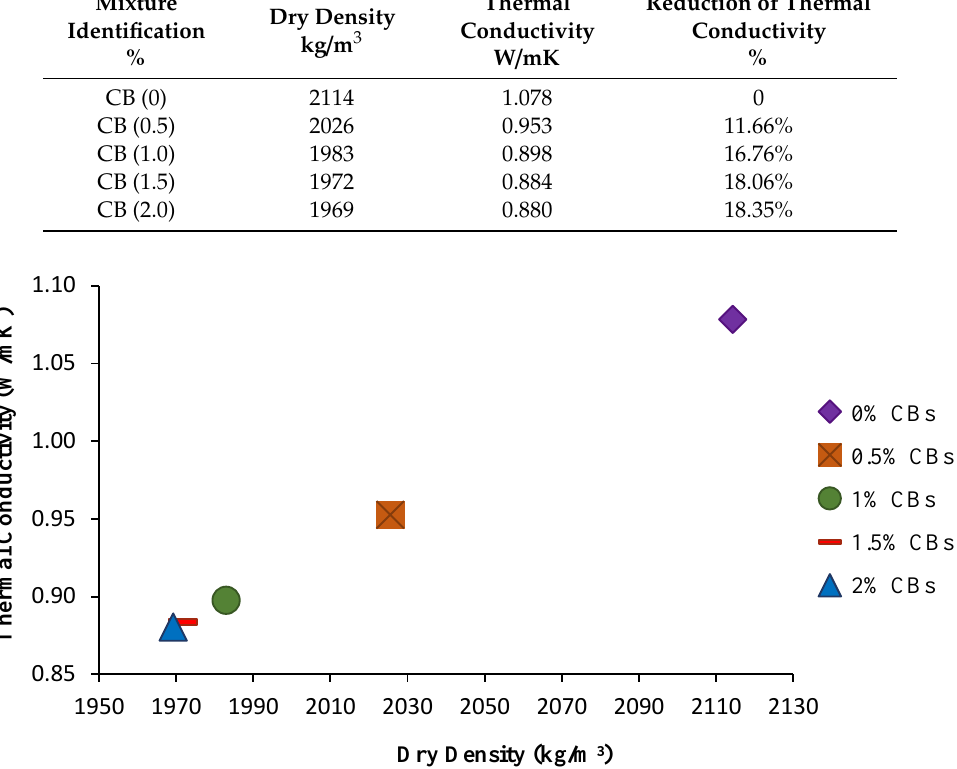
Table 4. Energy savings between a fired clay brick wall with 0% CB content and 0.5%, 1%, 1.5%, and 2%